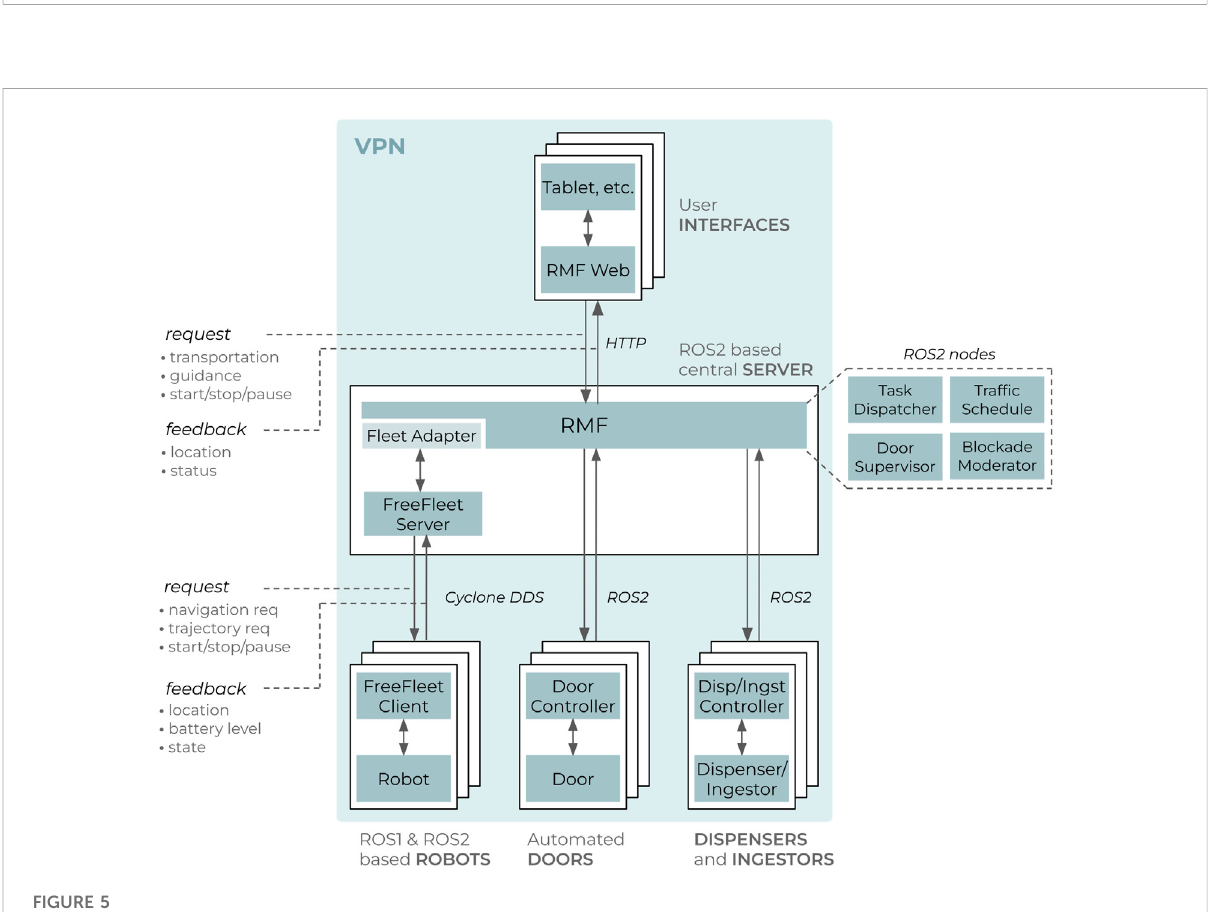
FIGURE 5 High-level architecture of the deployed